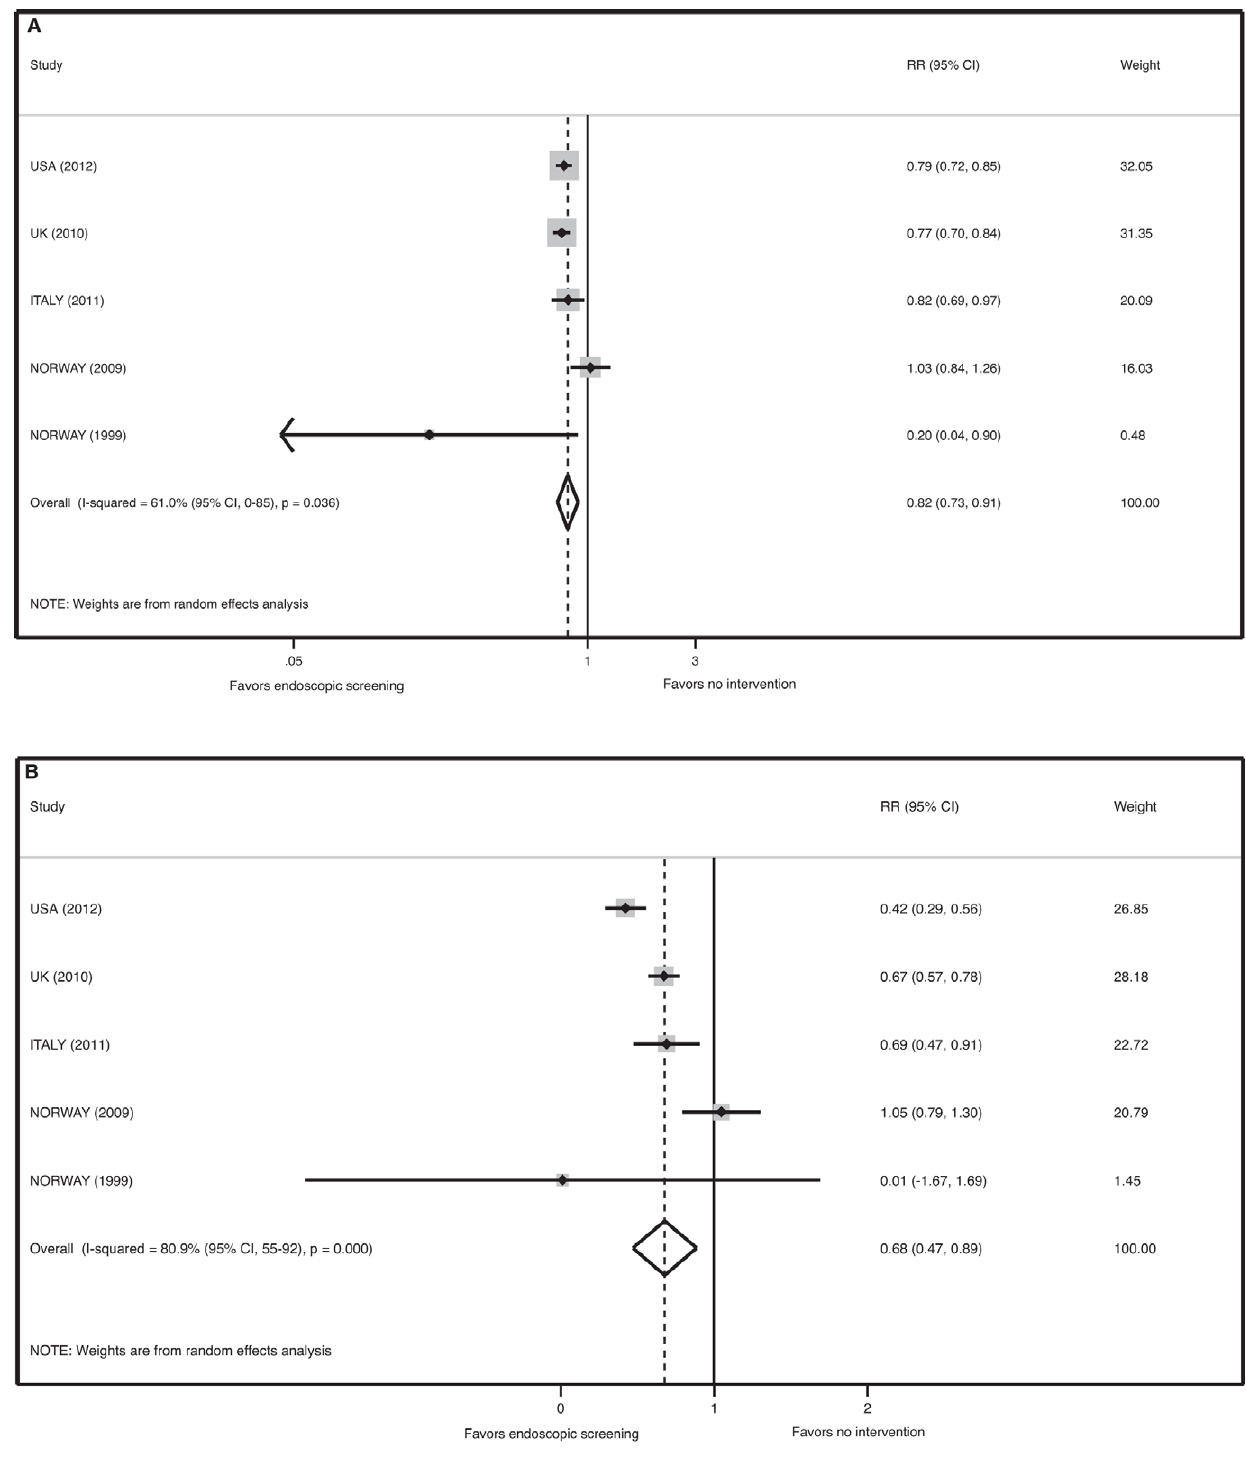
Figure 2. Meta-analysis of the effect of endoscopic screening on the incidence of colorectal cancer. (A) Pooled relative risk of ITT analyses. (B) Pooled relative risk of efficacy estimates.